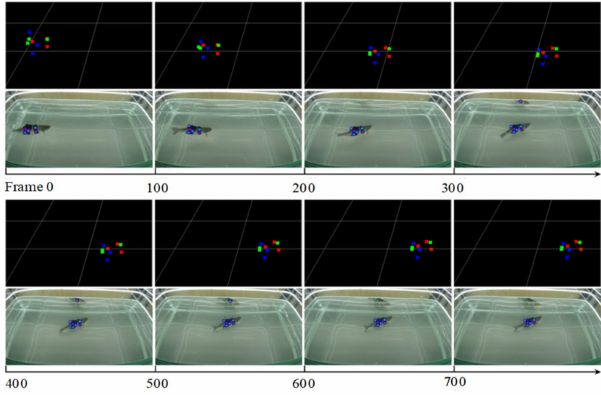
Figure 20. D reconstruction results in software and pictures captured by camera.